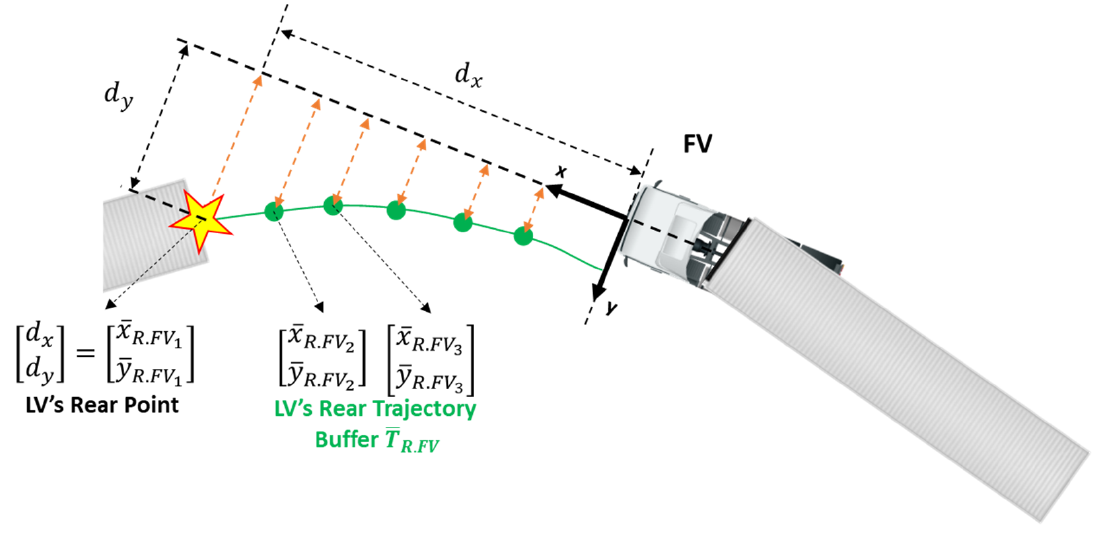
Figure 13. LV’s rear bumper trajectory from the viewpoint of FV.